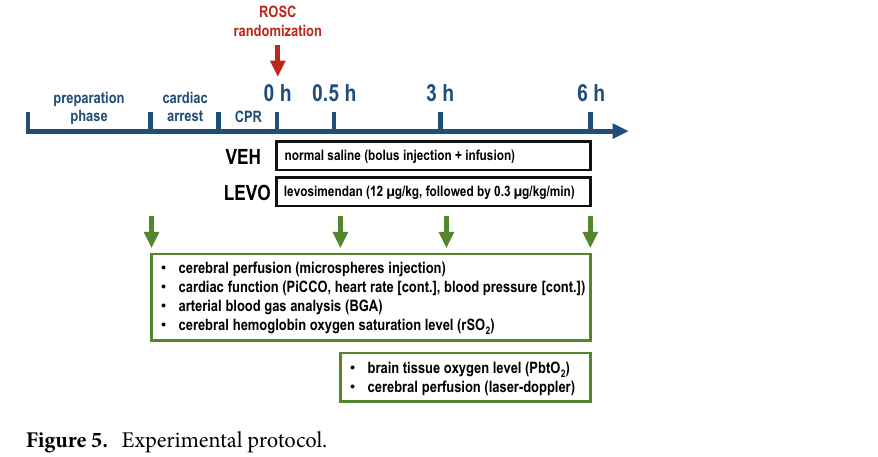
Figure 5. Experimental